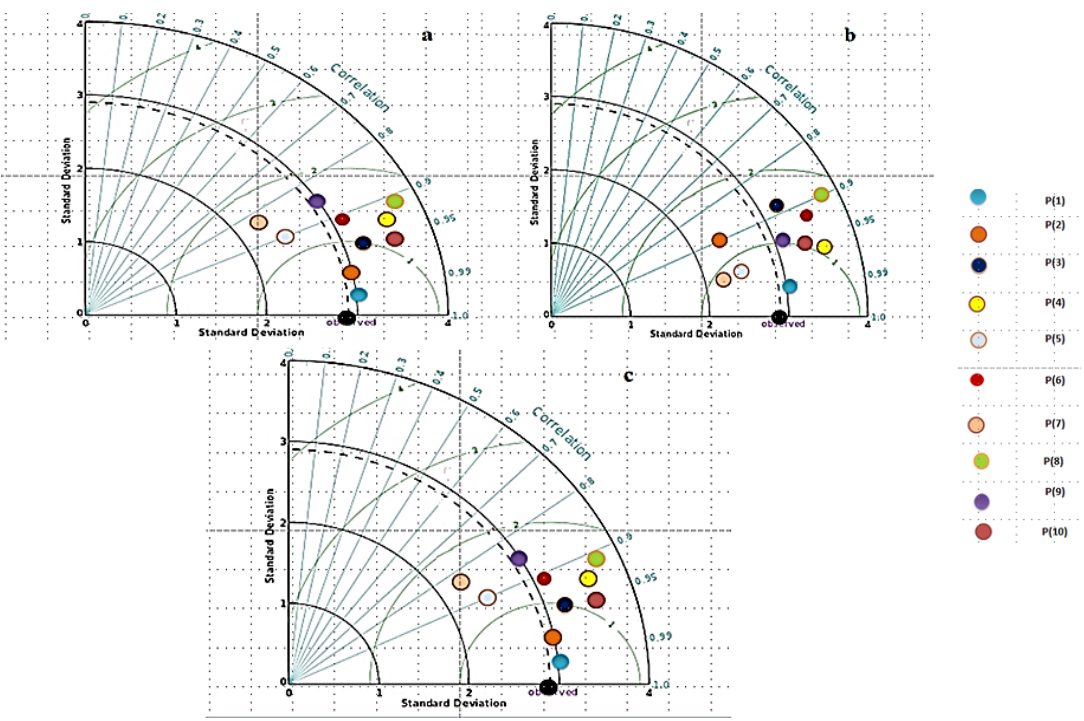
Figure 7. The results for the Pareto solutions for ( a ) EAZP, ( b ) AP, and ( c )